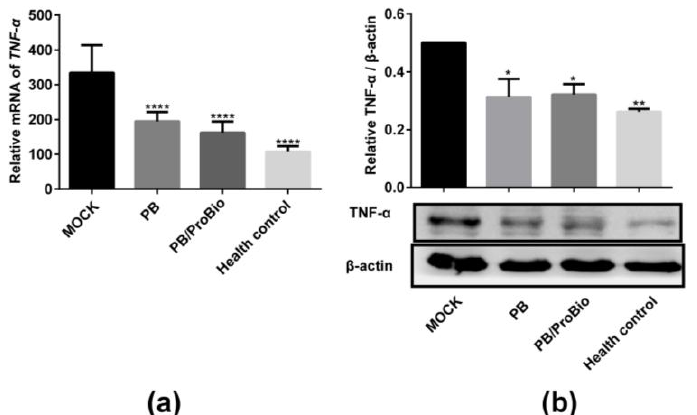
Figure 3. The effect of prebiotic blend (PB) and probiotics on modulating Tnf-a expression in colon tissues. The relative mRNA of each group was shown by mean value ± SEM, n = 8 for each group. ( a ) The relative mRNA of Tnf- α in the 4 groups. **** p < 0.0001. ( b ) Upper panel: Relative intensity of TNF- α protein expression calculated as the ratio of TNF- α vs. β -actin. * p < 0.05, ** p < 0.01. Lower panel: Western blot analysis of TNF- α in MOCK, PB, PB/ProBio, and Health control groups.